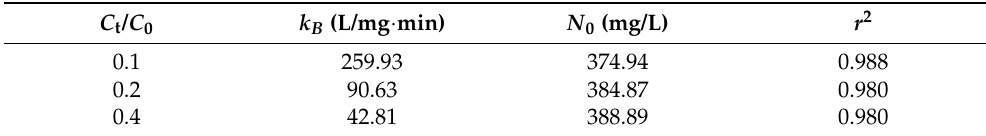
Table 3. Calculated data experiment conducted in the BDST